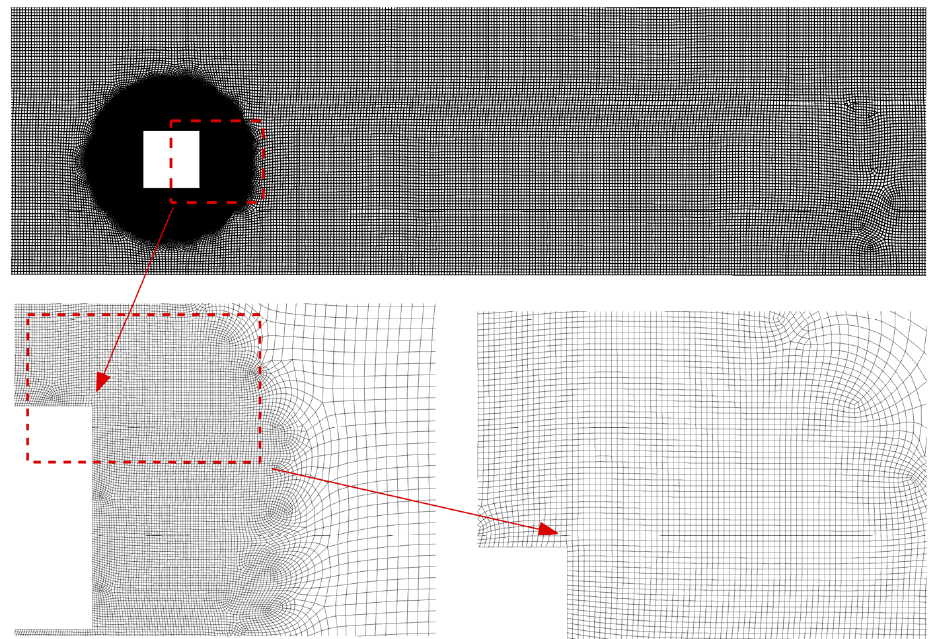
Figure 2. The mesh domain and mesh distribution around the submerged body.